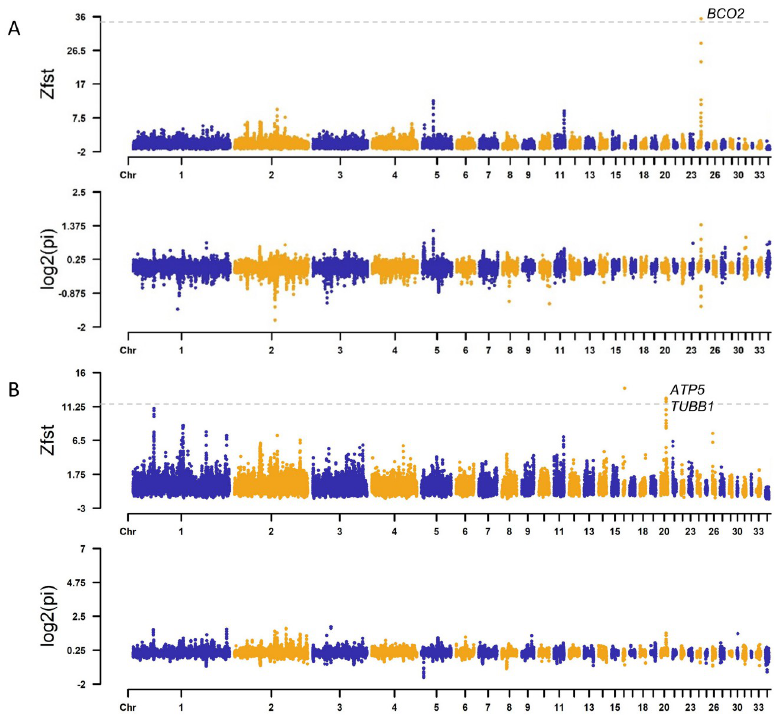
Fig 4. The result of ZFst and Log2(pi) of Guangxi chicken. (A) Yellow skin and non-yellow skin chickens. (B) WC and other indigenous breeds. The horizontal dotted lines represent the top 1% cut-off.